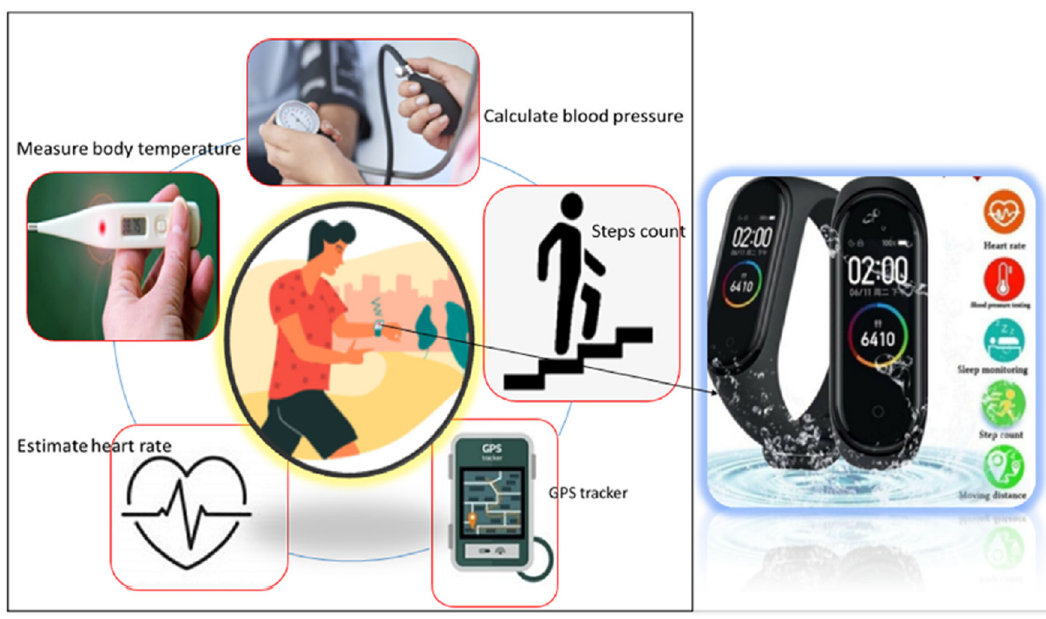
Figure 12: Diagrammatic representation ( Vital 3.0 ) [ 83 ] .